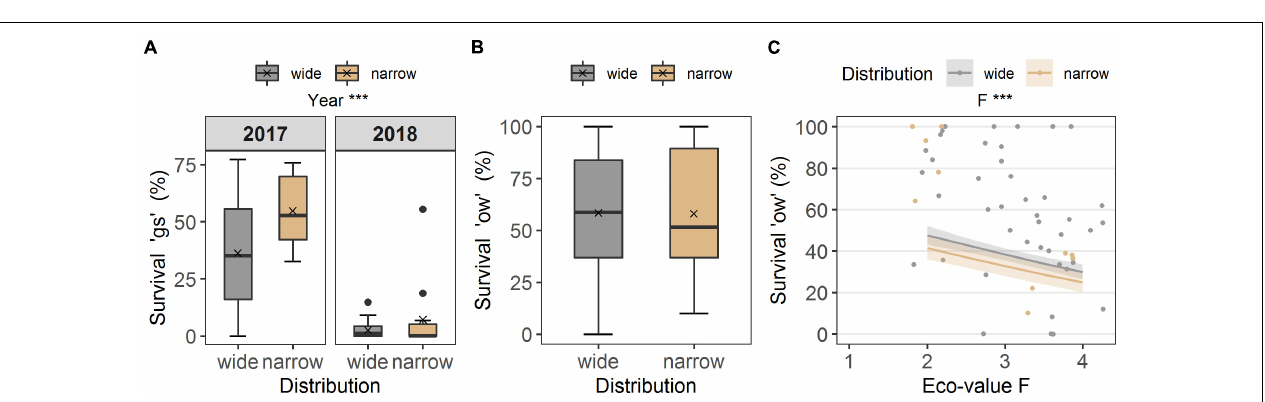
FIGURE 3 | (A) Emergence percentage in the common garden, grouped in distribution (wide, narrow), at each recording date (i.e., every 2 weeks). Bars denote mean at each recording date, error bars denote ± standard errors. Boxes in (B) emergence percentage and (C) MTE (recording date) illustrate the interquartile range with the median as line; whiskers illustrate the minimum and maximum; points denote outliers; x denotes the mean. Points without border in (D) emergence percentage (E,F) , MTE, denote the observed values colored according to distribution along ecological indicator values H (humus) and T (Temperature value); points with border denote the estimated means per ecological indicator value life form (c, chamaeophyte; h, hemicryptophyte; t, therophyte), and colored ribbons denote confidence intervals from the models [missing in (D) to simplify the graph]. Note different maxima on y -axis between panels. Stars denote significances at α = 0.01 (**) and α = 0.001 (***).